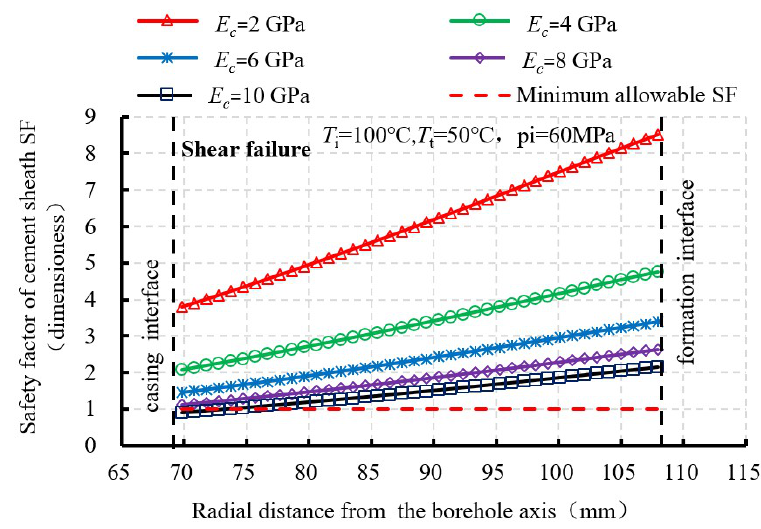
Figure 17. Radial distribution of the cement sheath safety factors for shear failure under a different elasticity modulus of cement sheath.